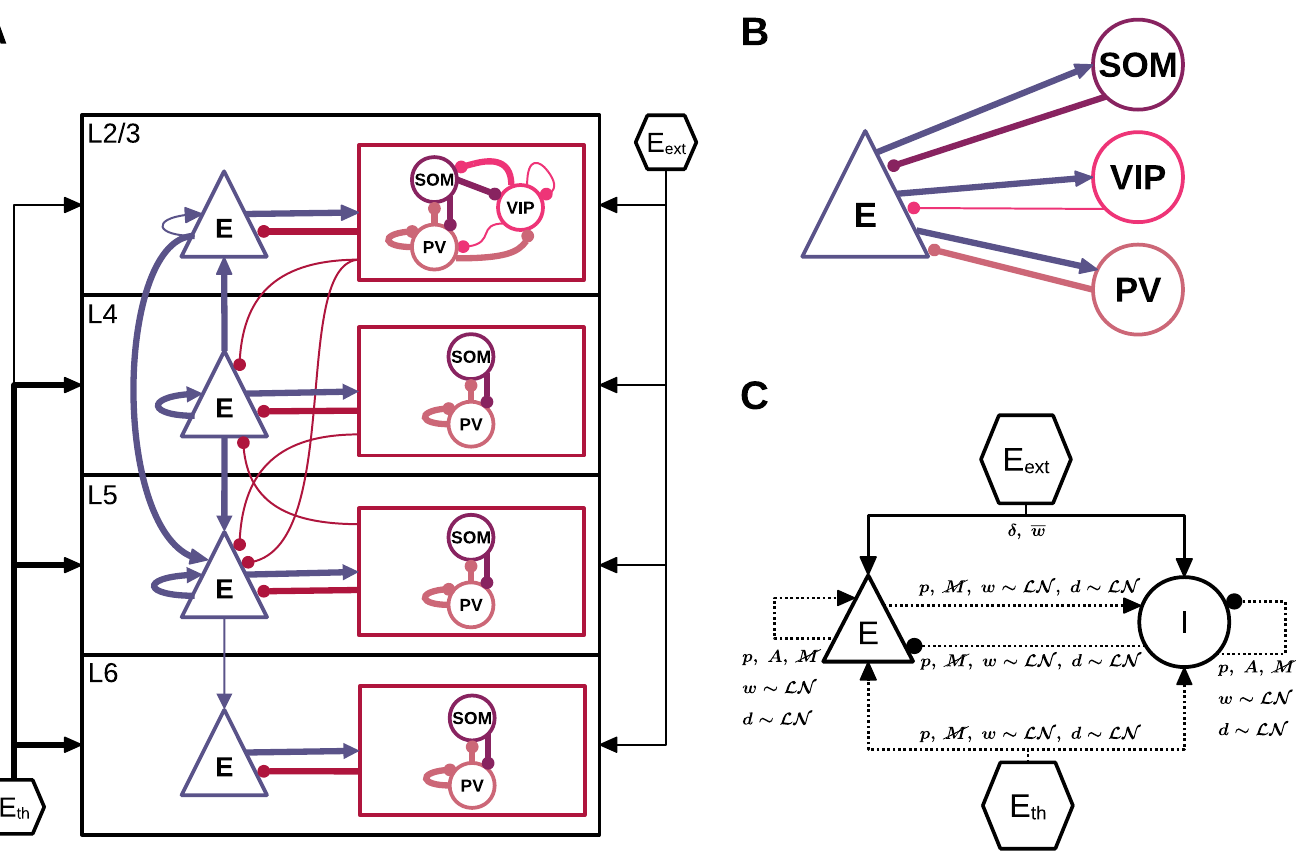
Fig 10. Multi-layer microcircuit model with three inhibitory neuron types. (A) Schematic overview of all neuronal populations, external inputs, and main connections. Inhibitory populations are grouped by boxes. In panels A and B, for probabilistic connections, only those with a probability of at least 4% are shown (thin lines: 4 to 8%, thick lines: � 8%). (B) Detailed L2/3 connectivity between excitatory population and all three inhibitory populations; in panel A these connections are combined in two arrows (from and to the box). (C) Excitatory-inhibitory subnetwork with external inputs depicted with annotations according to the graphical notation in Fig 8. The connectivity is described with the rules “one-to-one” ( δ ) and “pairwise Bernoulli” ( p ), and the constraints autapses allowed ( A ) and multapses prohibited ( = M ). The synaptic weights ( w ) and delays ( d ) are specified as either constant (i.e., w ) or sampled from lognormal distributions (i.e., w � LN ). Interneuron types: somatostatin expressing (SOM), vasoactive intestinal peptide expressing (VIP), parvalbumin expressing (PV).